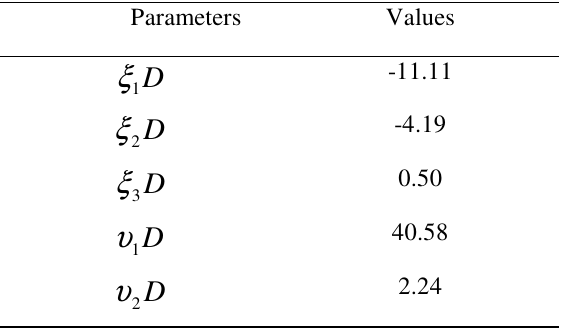
Table 3 Values of third-order potential parameters (in G Pa) of LiNbO